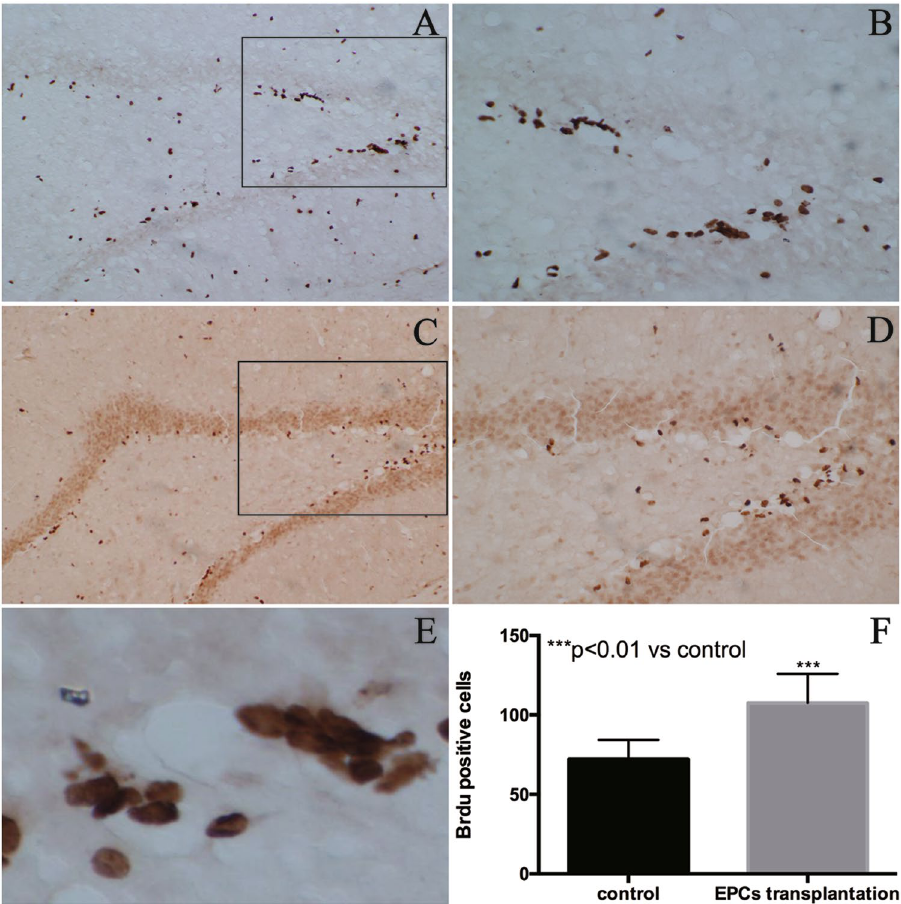
Figure 7. Neurogenesis in the DG of adult hippocampus after EPC transplantation. BrdU + cells expression in the DG of the hippocampus of the EPCs transplanted group ( A , B ) and the control group ( C , D ). The BrdU-positive cells in the hippocampus were in clusters ( E ). The number of BrdU-positive cells in the adult hippocampus increased after EPC transplantation as compared to the control (P < 0.05 versus the control group, 100 × ). Data are presented as means ± SD ( F